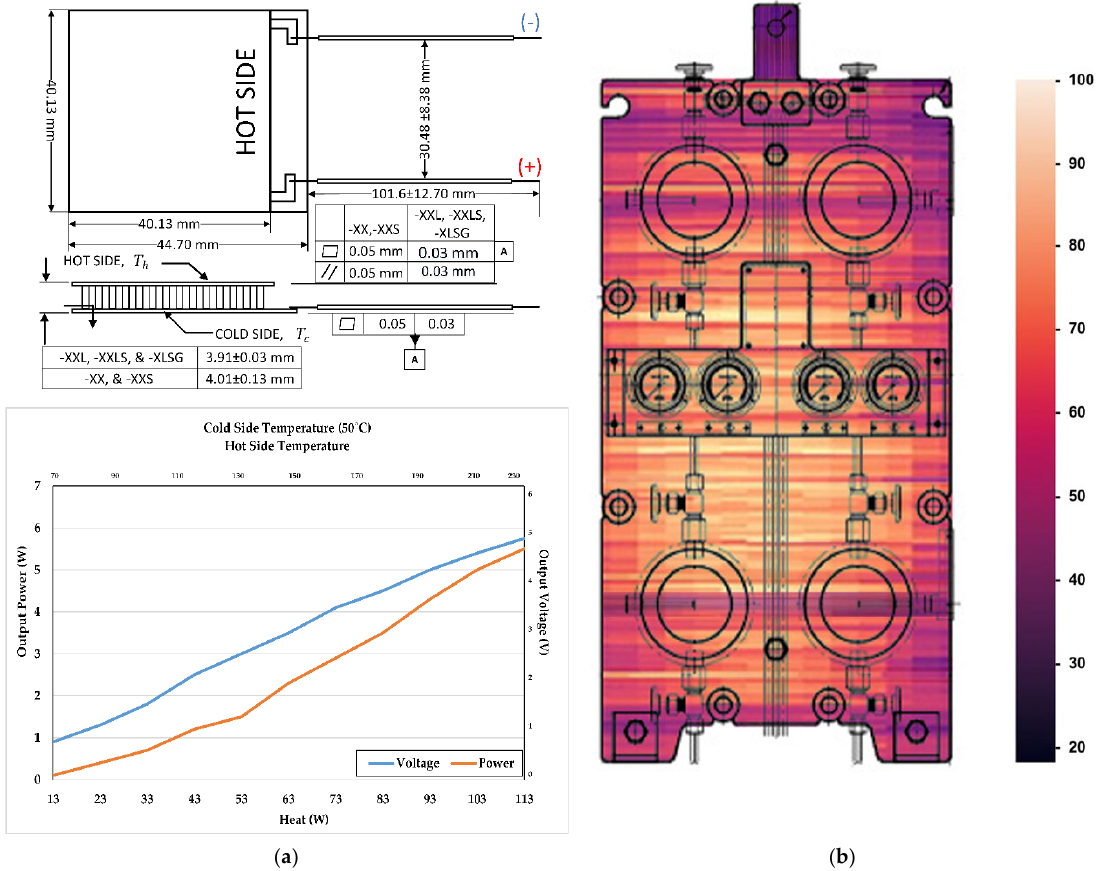
Figure 4. ( a ) The characteristics of the TEG [36]; ( b ) Heat map of ME JCW heat exchanger (°C).